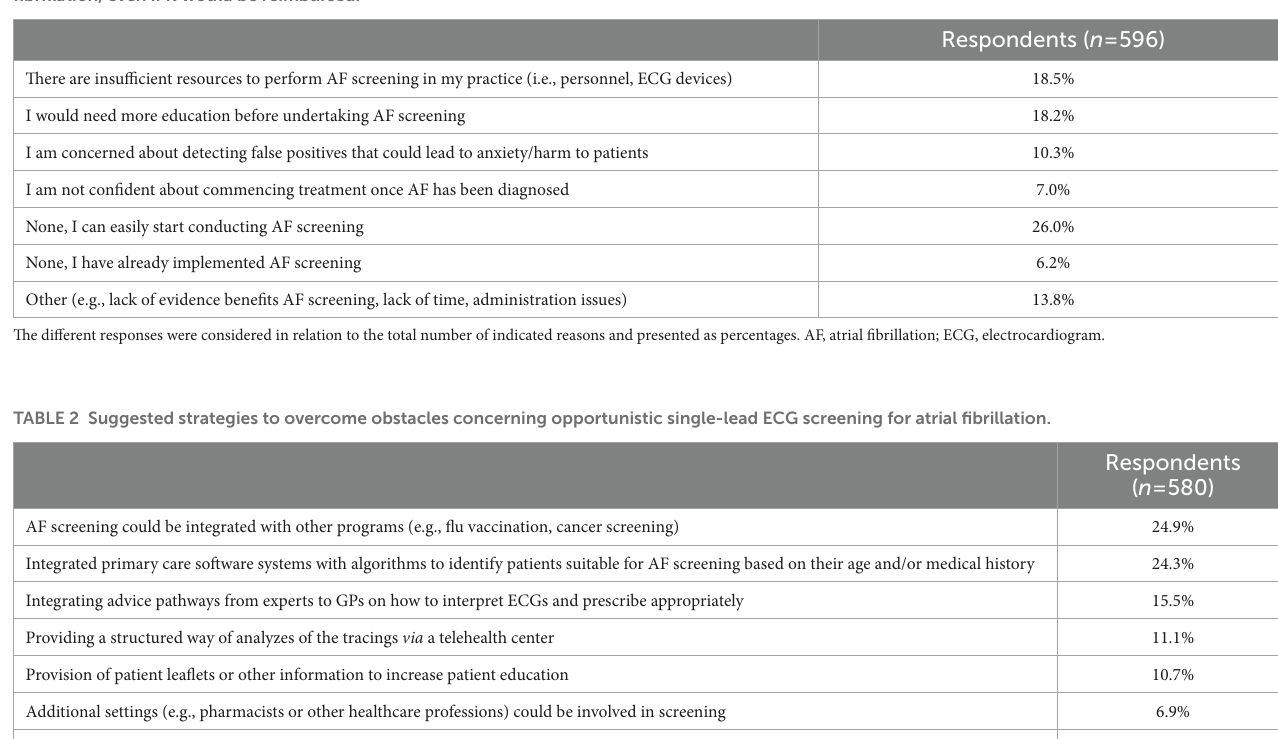
TABLE 1 Main obstacles for implementing opportunistic single-lead ECG screening for atrial fibrillation in patients ≥ 65 years or patients at risk of atrial fibrillation, even if it would be reimbursed.